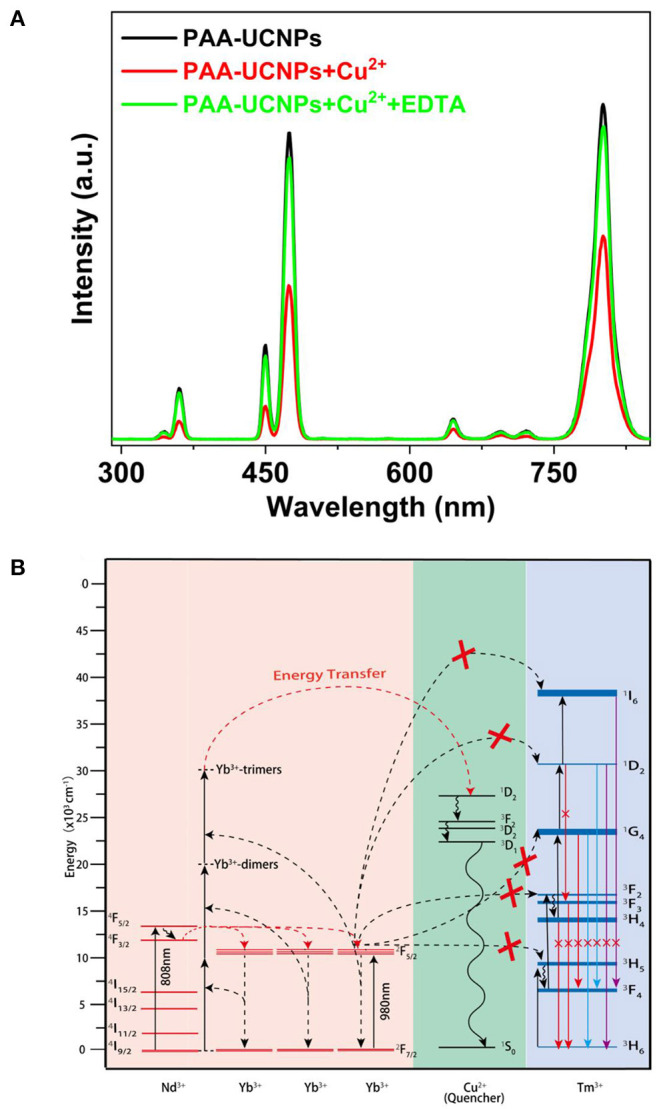
(A) Photoluminescence spectra of PAA-NaYb0.5Nd0.5F4@NaYb0.5Gd0.49Tm0.01F4@NaGdF4 UCNPs without Cu2+, with Cu2+ (2.0 μM), and further addition of EDTA (2.0 μM) under 980 nm laser excitation; (B) The proposed energy transfer mechanism between NaYb0.5Nd0.5F4@NaYb0.5Gd0.49Tm0.01F4@NaGdF4UCNPs and copper ions.